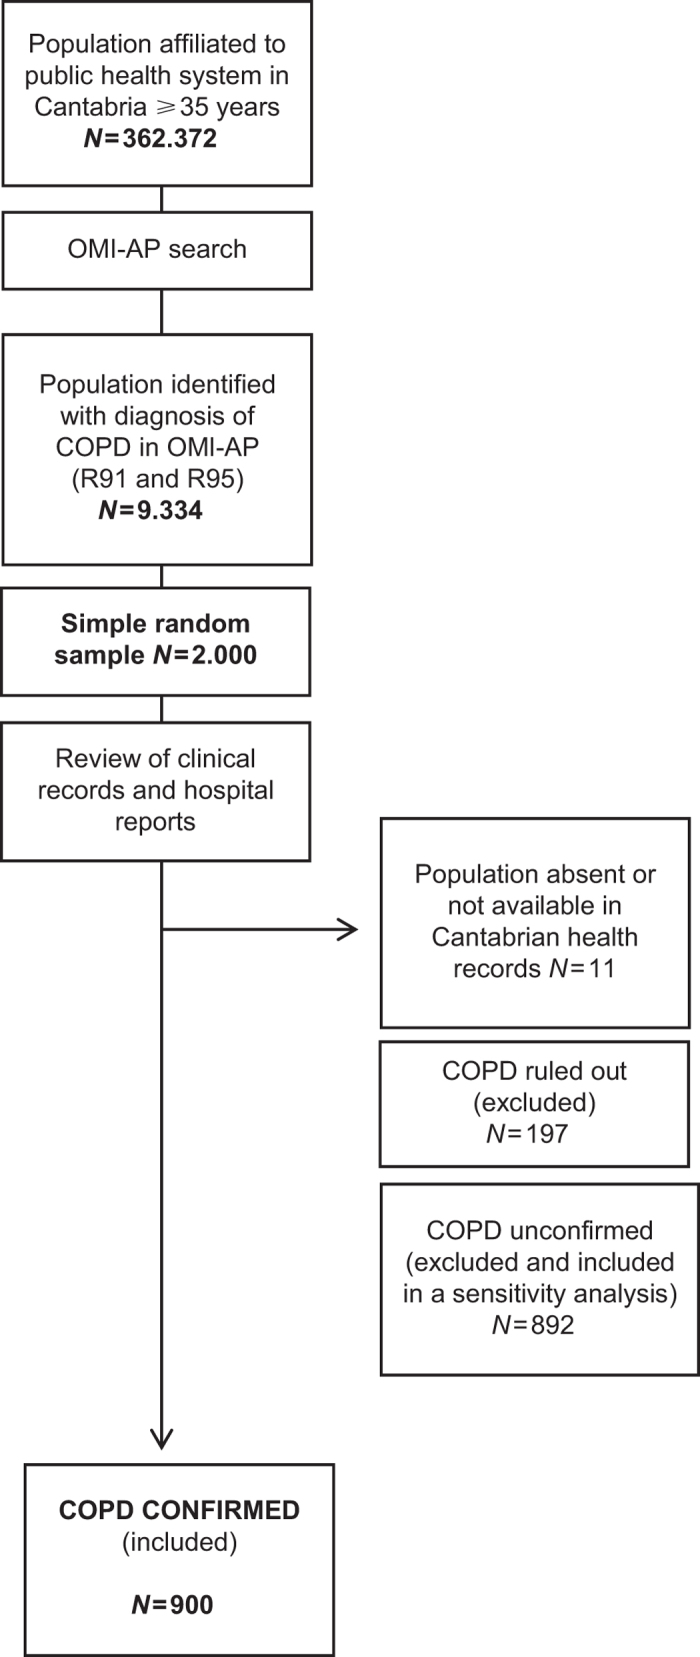
Flow chart for selection of the study sample.